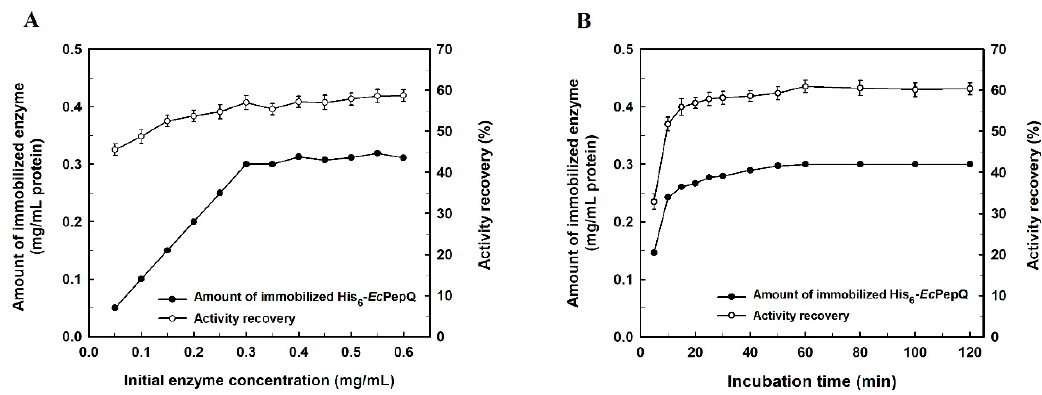
Figure 2. Effects of initial enzyme concentration ( A ) and coupling time ( B ) on the immobilization efficiency of His 6 - Ec PepQ. In these experiments, enzyme samples were incubated with 0.2 mg/mL of NiNTASiMNPs.